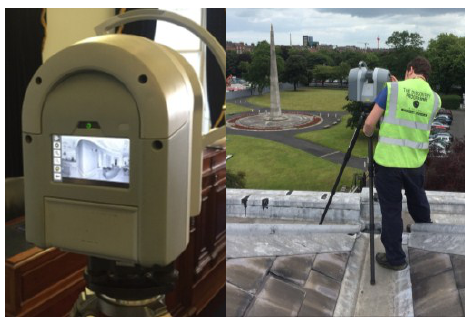
Figure 3: Time of Flight Scanner